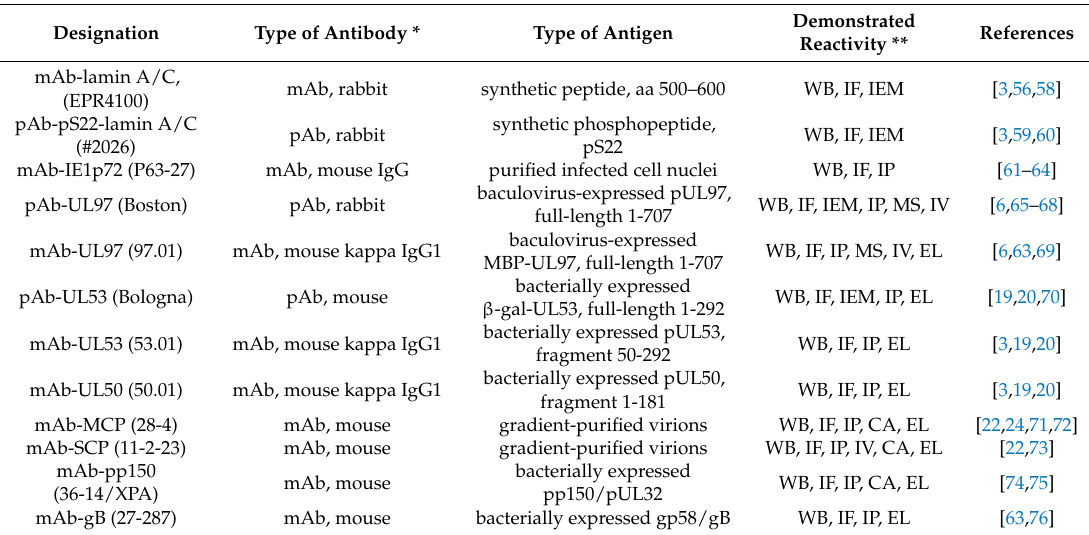
Table 2. Basic characteristics and specific reactivities of antibodies used in this